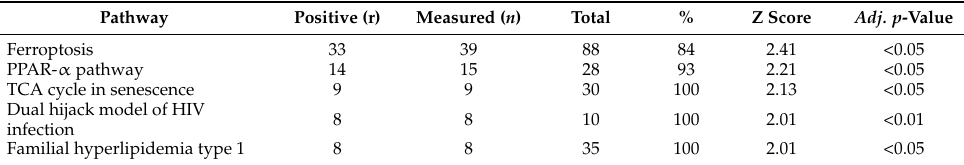
Table 5. Pathways overlapped in AFB1-OTA-exposure (100 nM) by PathVisio. Pathway